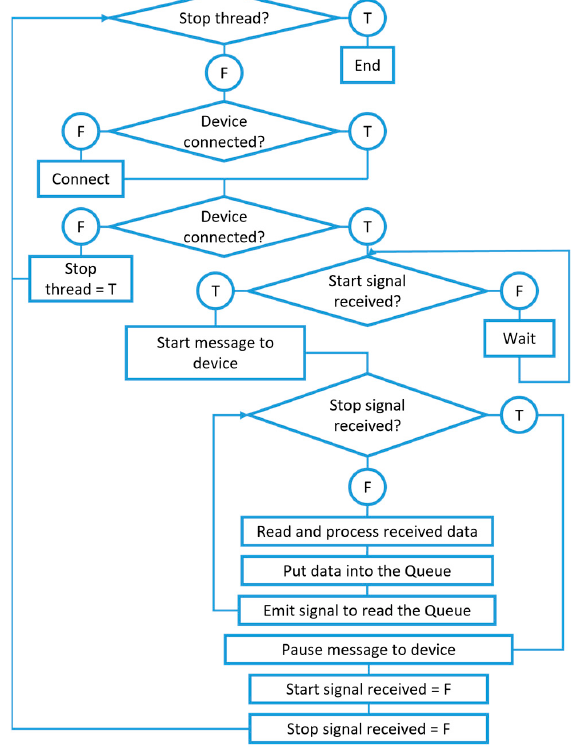
Figure 6. Serial communication thread code structure representation.